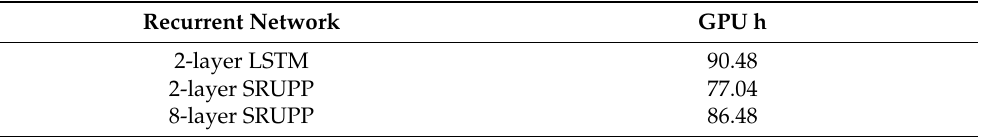
Table 4. The training GPU hours for the model using 2-layer LSTM, 2-layer SRU++, and 8-layer SRU++ at 150 epochs on 4